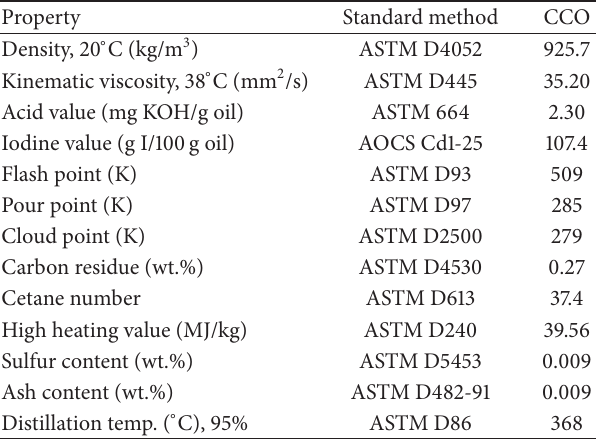
Table 1: Physical and chemical properties of CCO. Property